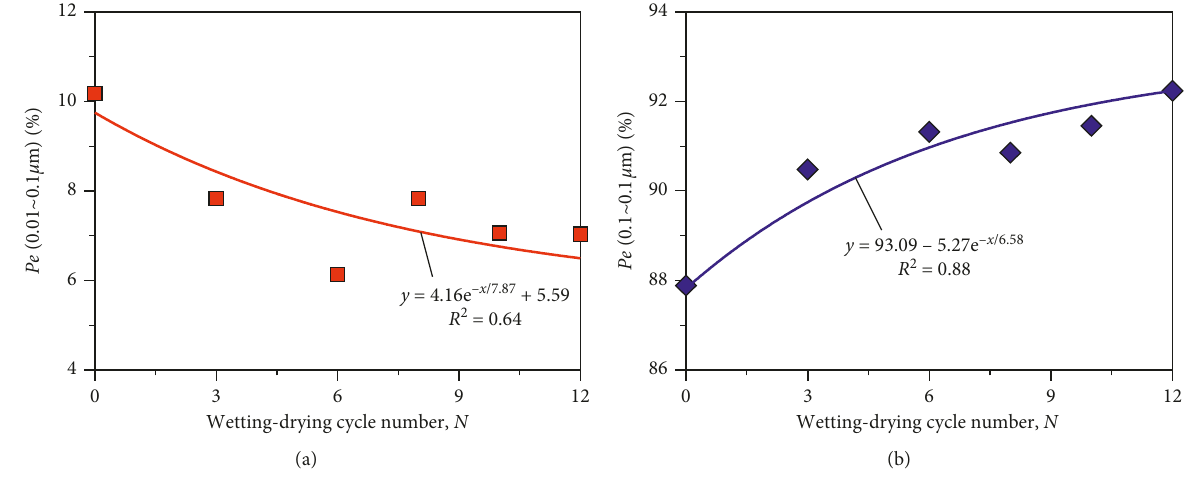
Figure 13: Variations in Pe (0.01 ∼ 0.1 μ m) and Pe (0.1 ∼ 1.0 μ m) versus the wetting-drying cycle